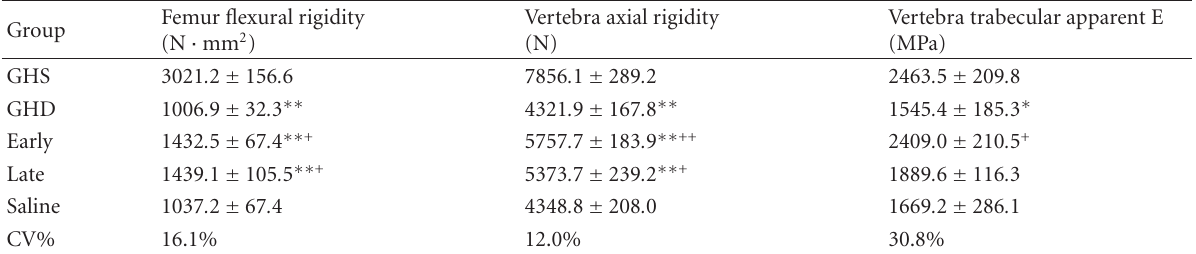
Table 3: Mechanical properties in GH-su ffi cient (GHS), GH-deficient (GHD), early treatment (early; daily GH injections from age 21 to 60 days), late treatment (late; daily GH injections from age 35 to 60 days), and saline control (saline; daily saline injections from age 21 to 60 days). Mean and standard errors are reported, and the coe ffi cient of varation (CV%). ∗ P ≤ 0 . 05, ∗∗ P ≤ 0 . 001 versus GHS, + P ≤ 0 . 05, ++ P ≤ 0 . 001 versus